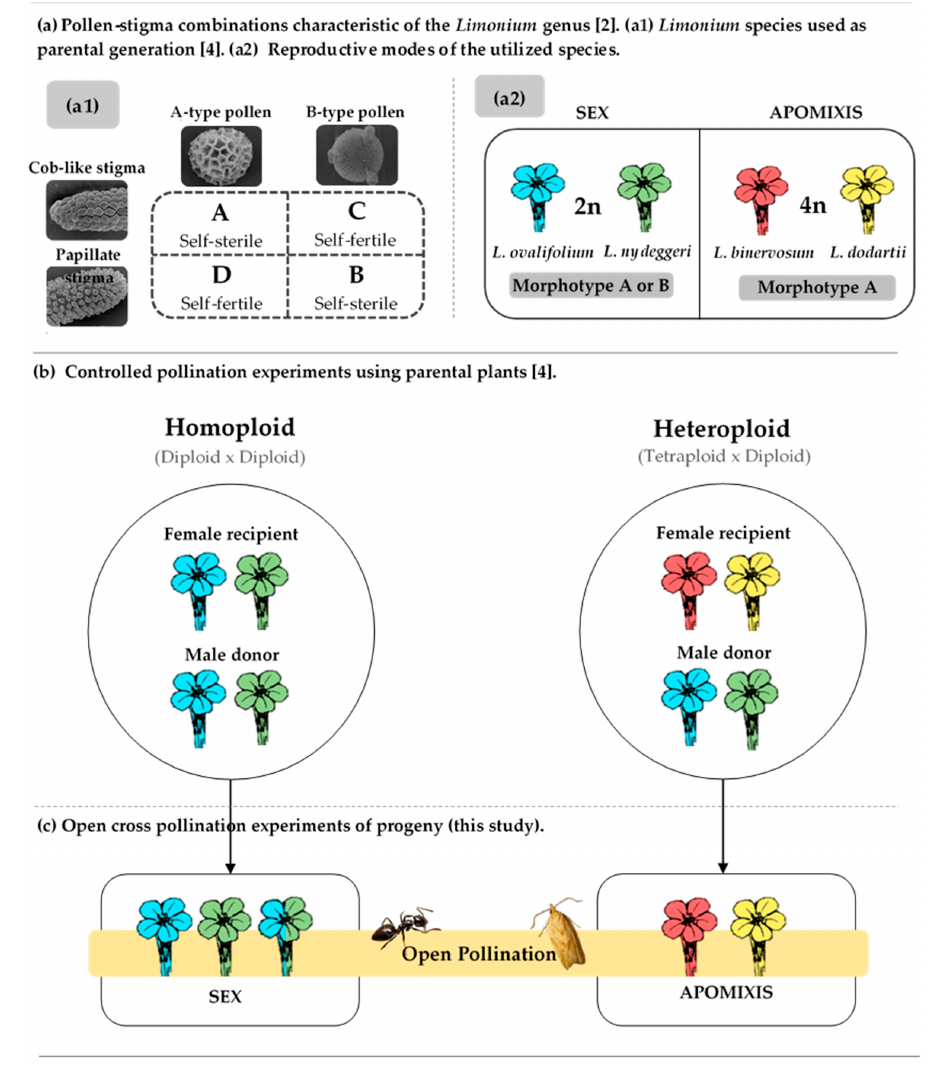
Figure 1. Workflow of the homoploid and heteroploid crosses performed in Limonium plants from a controlled ex situ crossing experiment, adapted from [4,7]. For schematic purposes and easy understanding of this figure, the meaning of the color code used for the flowers in section A is maintained throughout the remaining figure sections. In section ( a ), the pollen (A and B) and stigma types ( cob -like and papillate) found in the Limonium genus [7] are represented and exemplified by L. binervosum , L. dodartii , L. nydeggeri, and L. ovalifolium . Pollen grains with macroreticulate exine germinate on papillose stigmas surfaces, whereas pollen grains with microreticulate exine germinate on cob -like stigmas [1]. Section ( b ) shows the parental species previously characterized in [7] and utilized in the controlled homoploid (diploid × diploid) and heteroploid (tetraploid × diploid) crosses realized in spring 2016 [4] as well as female recipients and male donors used in each cross. The resulting offspring plants were characterized in terms of morphology, ploidy levels, and reproductive modes as assessed by nuclear ribosomal DNA analyses in 2017–18 [4,7]. Section ( c ) represents the plants reproductively characterized in this study. These plants were subjected to open pollination and allowed to be visited by insects in 2019 within a semi-closed